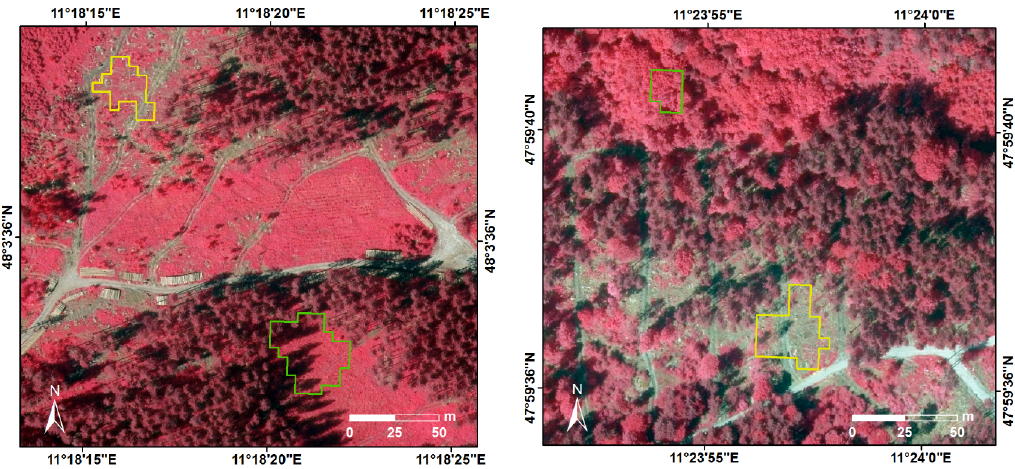
Figure 4. Example reference polygons showing different windthrow areas (yellow polygons) as well as non-windthrow polygons (green polygons). Polygons are overlaid on a false color composite orthophoto (band combination: near infrared—red—green) acquired four months after the storm.